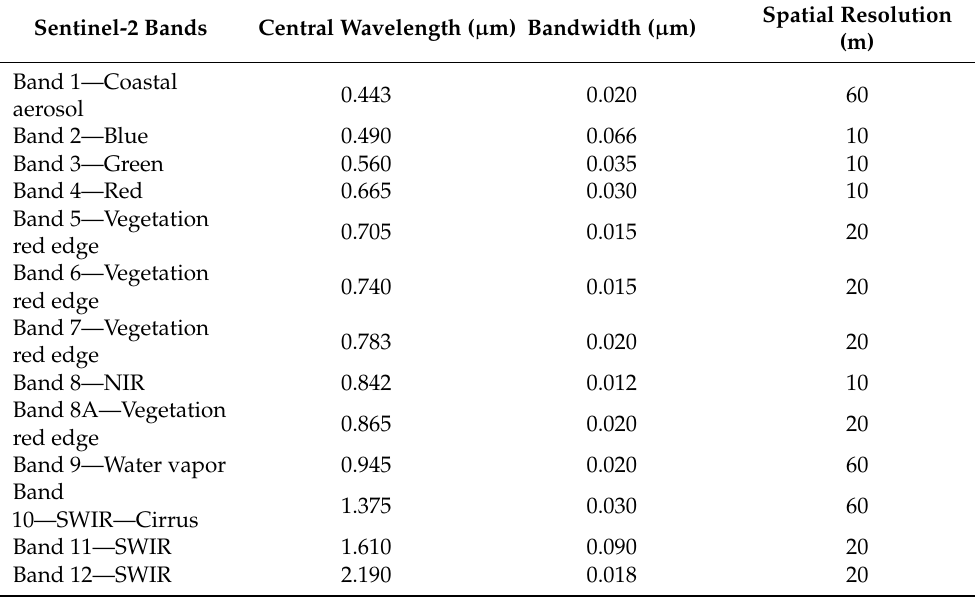
Table 1. Spatial resolution bands of Sentinel-2 Level 2A; NIR stands for near-infrared, and SWIR is short-wave